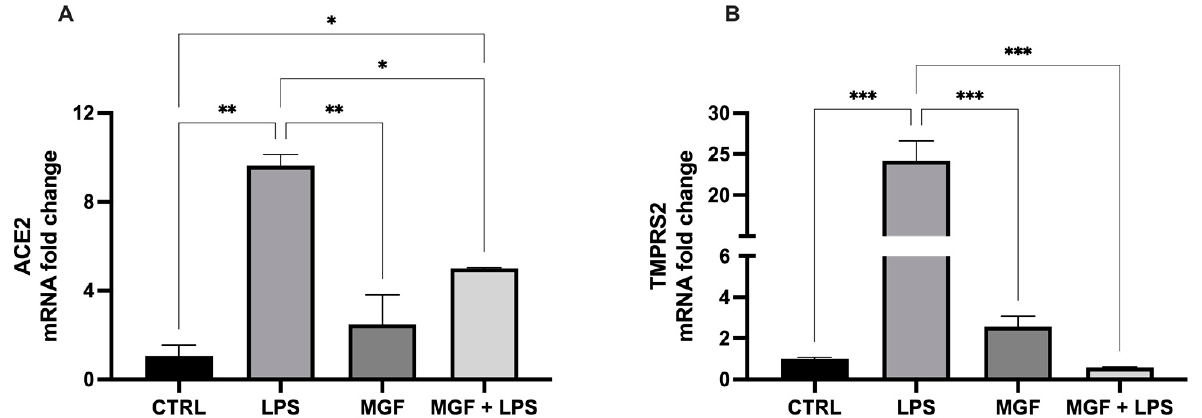
Figure 3. mRNA expression of ACE2 ( A ) and TMPRSS2 ( B ) in NCI-H292 cells. Cells were treated with LPS 10 µ g/mL for 1 h, and with MGF 20 µ g/mL for 24 h. * p < 0.05; ** p < 0.01; *** p < 0.001.